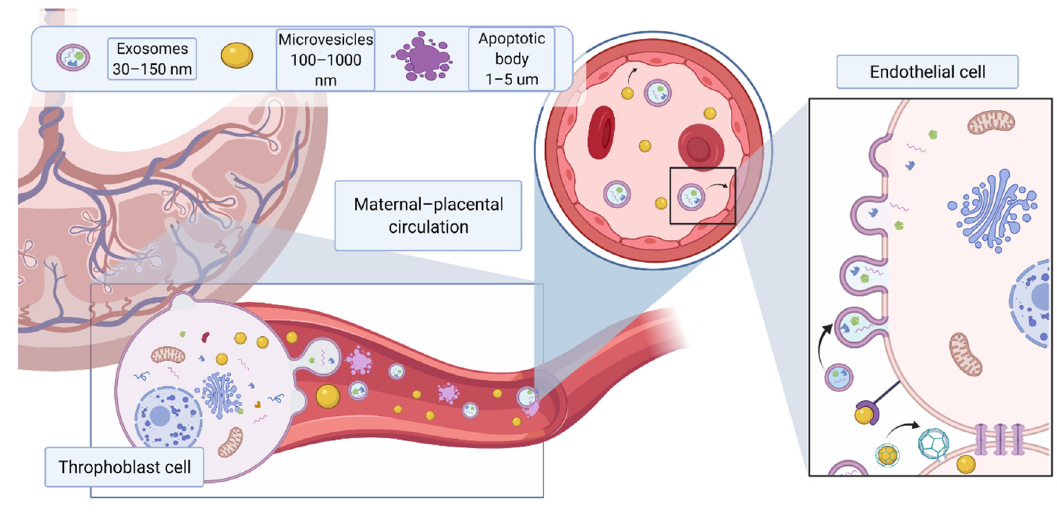
Figure 1. Different EV subtypes released from the placenta during pregnancy. The main subtypes of extracellular vesicles reported include exosomes (30–150 nm) formed from intracellular endosomal compartments and characterized by expression of tetraspanins (CD63, CD81, CD9); microvesicles (100 nm–1 µ m), which originate from cell plasma membrane, characterized by CD 40; apoptotic bodies (>1 µ m), which are released by apoptotic cells, express phosphatidylserine on their surface and caspase 3 and 7 internally. Due to their small size, EVs can cross the placental membrane and contribute to feto–maternal signaling. Placental EVs have been previously found in maternal circulation and shown to directly affect maternal endothelium. Created with BioRender.com (accessed on 18 May 2021).